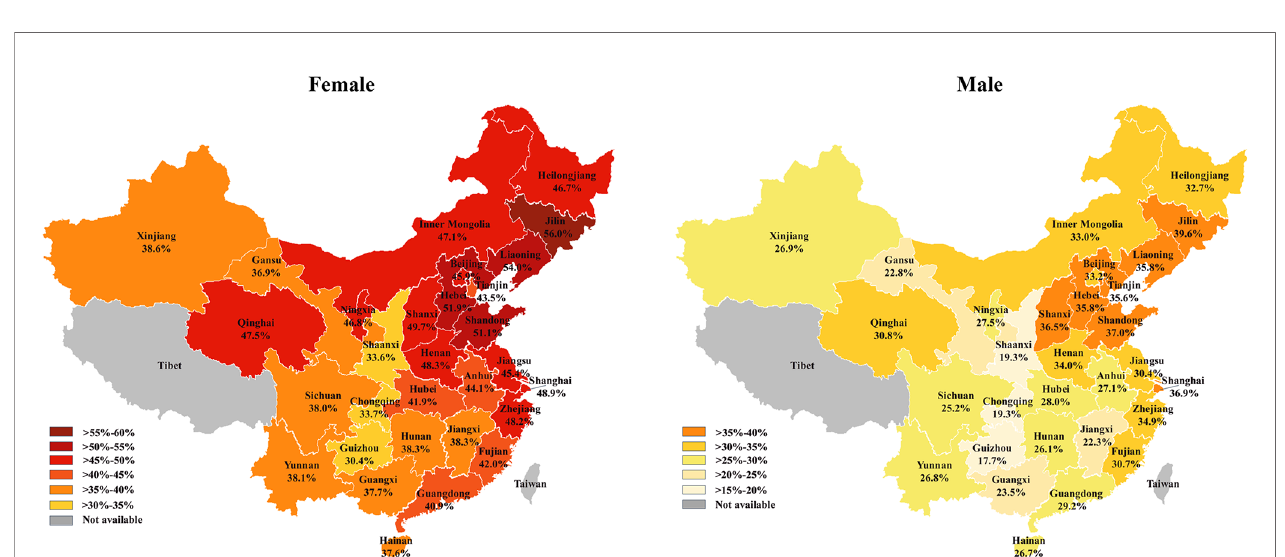
FIGURE 4 | The prevalence of thyroid nodules in females (left) and males (right) in China.